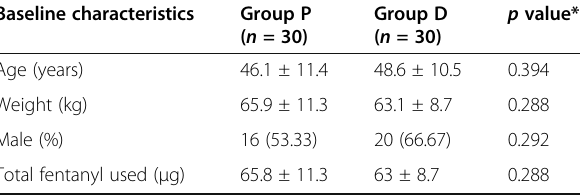
Table 1 Description of baseline characteristics in two group Baseline